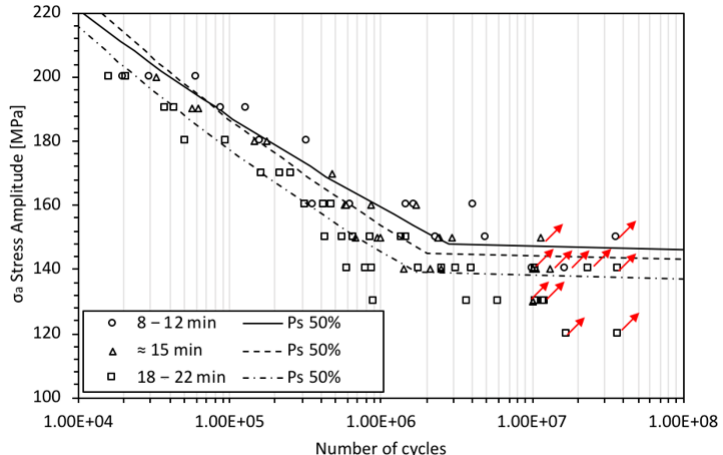
Figure 6. Fatigue life of specimens taken from different position within the cast samples. Solid line and dotted line represent the estimated fatigue curves at 50% survival probability for Y-shaped type III and type IV cast samples respectively. Run out specimens marked with an arrow.